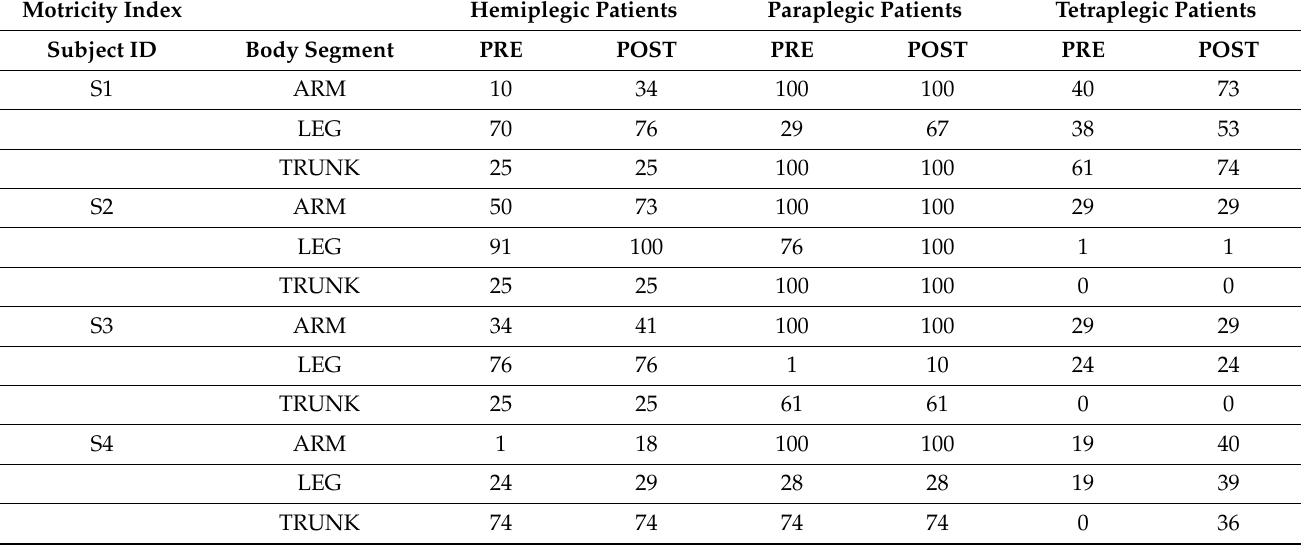
Table 5. Motricity Index for Arm, Leg and Trunk in Hemiplegic patients, paraplegic patients and Tetraplegic